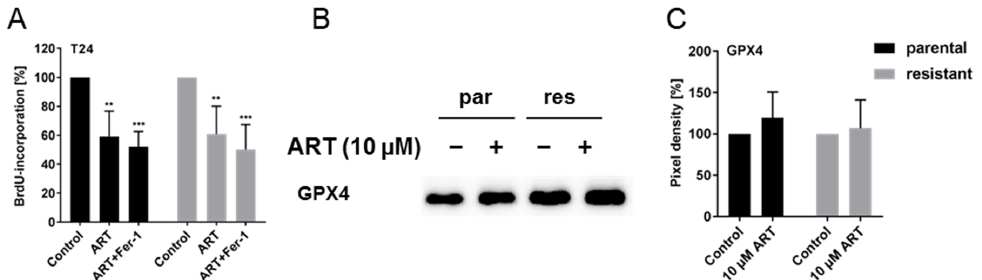
Figure 8. Ferroptosis: Cell proliferation of T24par and T24res after 72 h incubation with 10 µM ART alone or plus 20 µM ferrostatin-1 (Fer-1), a ferroptosis inhibitor, in percent ( A ). Untreated controls were set to 100%. Error bars indicate standard deviation ( SD ). Significant difference to untreated control: ** p ≤ 0.01, *** p ≤ 0.001. n = 3. Representative Western blot of GPX4 expression in T24 cells after 24 h exposure to 10 µ M ART ( B ). par = parental, res = resistant. Pixel density analysis of the GPX4 expression ( C ), compared to untreated controls (set to 100%) is illustrated. Each protein analysis was normalized by a total protein staining control. Error bars indicate standard deviation ( SD ). n = 4. For detailed information regarding the Western blots see Figure